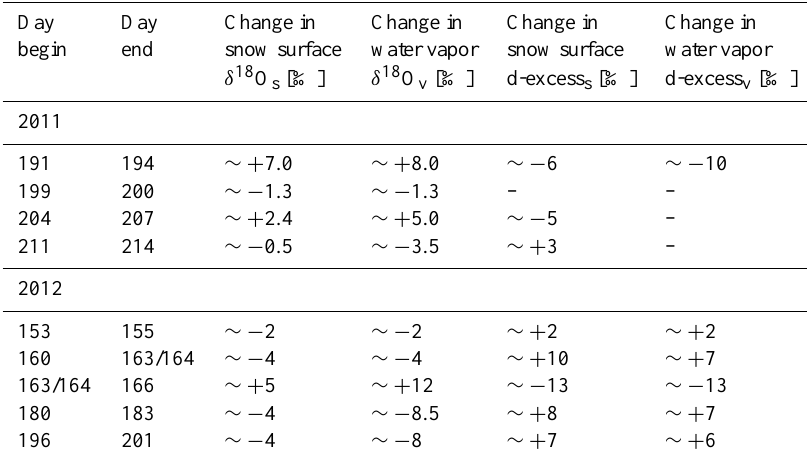
Table 4. Changes in surface snow and water vapor isotopic composition in between precipitation events. The value is calculated by comparing the mean over the specific days. Day Day Change in Change in Change in Change in begin end snow surface water vapor snow surface water vapor δ 18 O s [‰] δ 18 O v [‰] d-excess s [‰] d-excess v [‰] 2011 191 194 ∼ + 7 . 0 ∼ + 8 . 0 ∼ − 6 ∼ − 10 199 200 204 2012